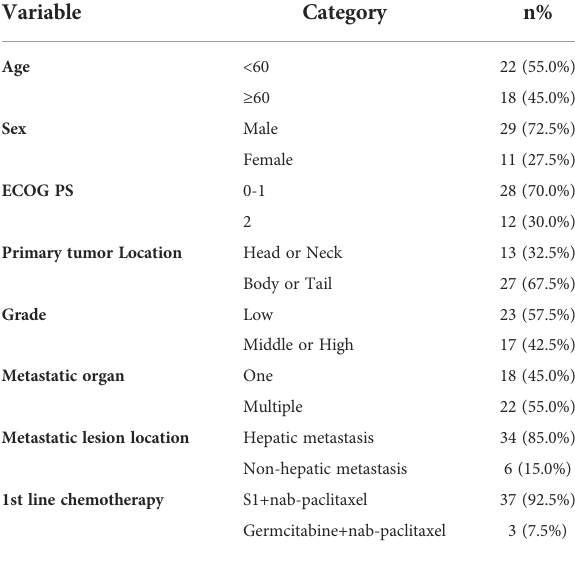
TABLE 1 Baseline characteristics of 40 metastatic PAC